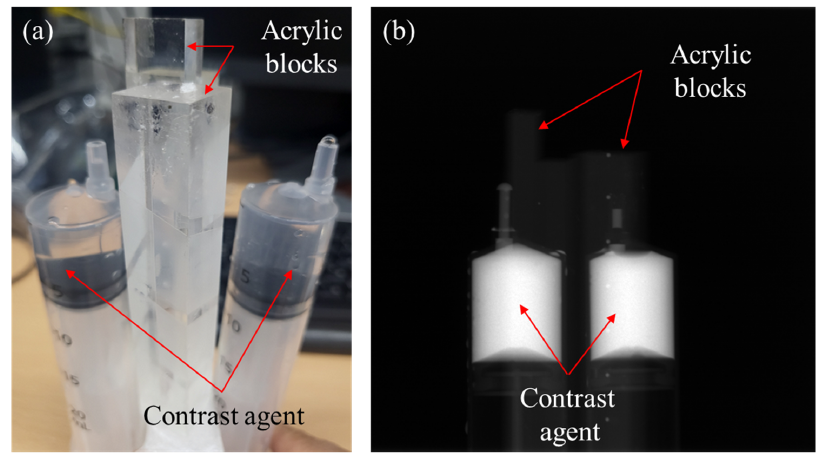
Figure 1. The contrast agent phantom consisting of two syringes filled with iodine solution (IO- HEXOL) and two acrylic blocks. ( a ) A photographic image of the phantom and ( b ) a projection image of the contrast agent phantom.